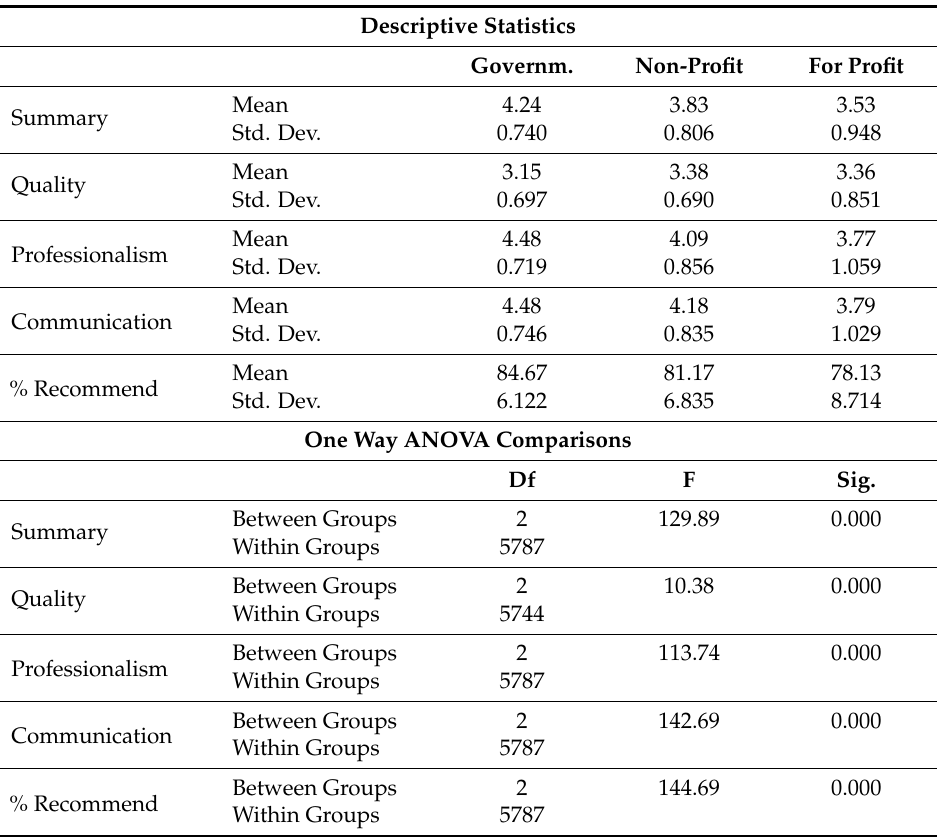
Table 6. Analysis of variance (ANOVA) analysis comparing ratings by proprietary